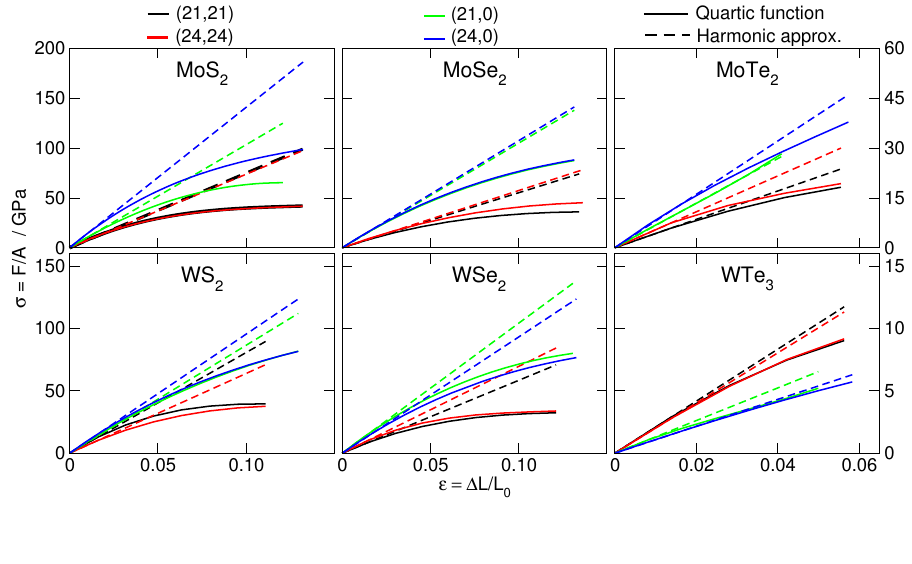
NTs under applied tensile strain along 2 2